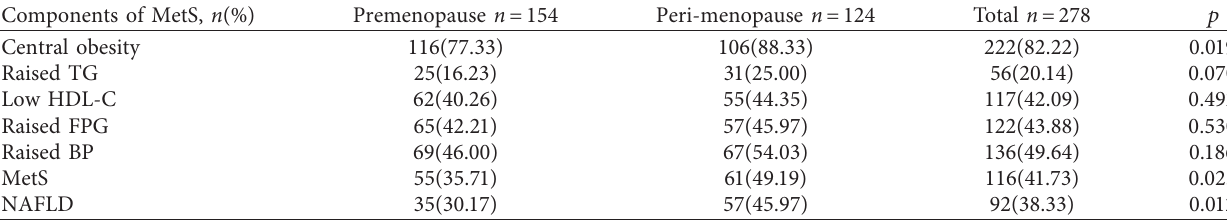
Table 2: The risk of Mets increased in perimenopausal females.